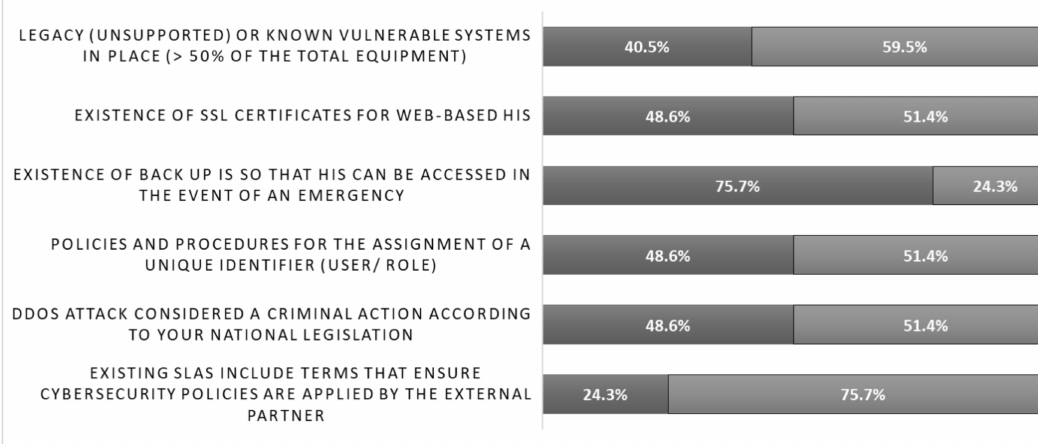
Figure 3. ICT personnel responses on common cybersecurity vulnerabilities.